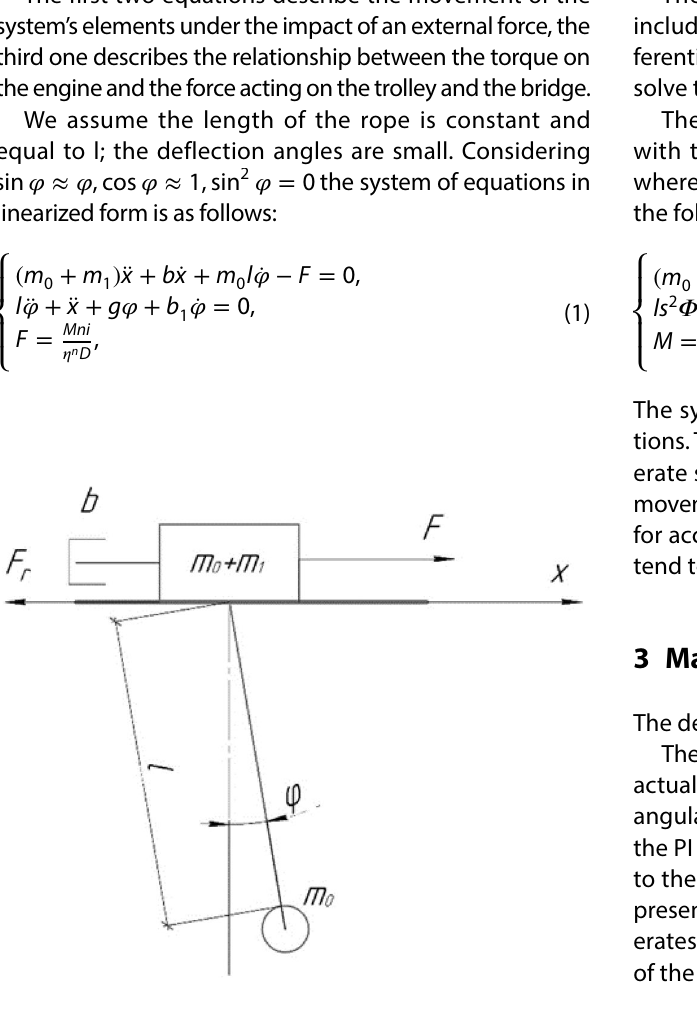
Fig. 1 Scheme of movement of a trolley with a load Fig. 2 Structure of the control